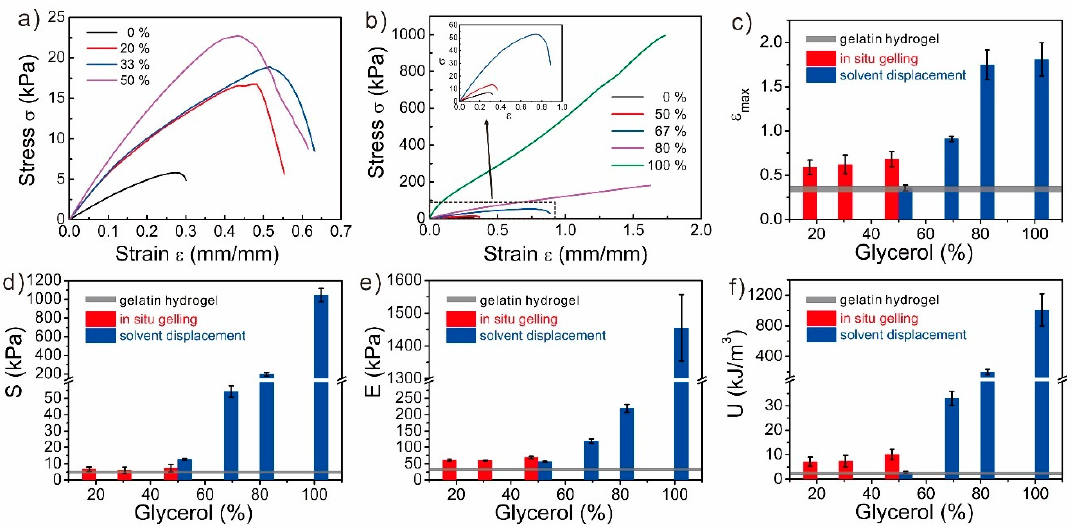
Figure 7. Mechanical properties of the gelatin gels with various glycerol contents from both synthesis strategies. ( a , b ) Stress-strain curves of the PAAm gels with various glycerol contents from ( a ) in-situ gelling and ( b ) solvent displacement. ( c ) Tensile strain, ( d ) tensile stress, ( e ) elastic modulus, and ( f ) toughness of the gelatin gels as the functions of the glycerol content. The horizontal grey lines ( c – f ) indicate the data from PAAm hydrogels, and the width of the line represents the error range.